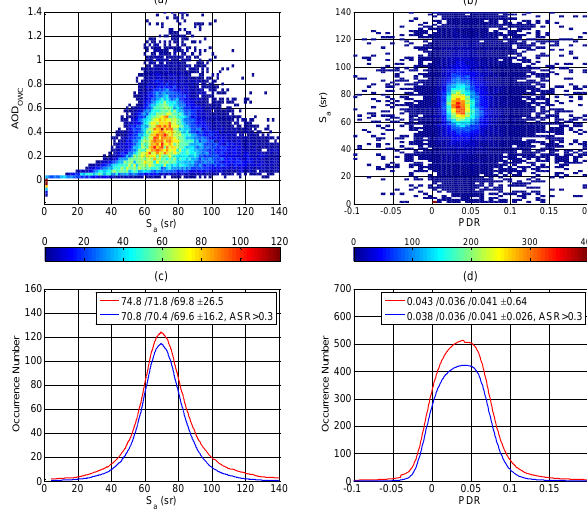
Figure 10. Analysis results for the smoke transport region as indi- cated by the red box in Fig. 7. The upper row shows 2-D distribu- tions of (a) AOD OWC vs. S a retrieved using AOD OWC as a con- straint and (b) S a vs. PDR, while the lower row shows histograms of (c) S a and (d) PDR occurrence frequencies. The S a distribution in (c) has a bin size of 0.1sr and is smoothed, while the bin size for S a in (a) and (b) is 1.5sr. The PDR distribution in (d) has a bin size of 0.001 and is smoothed, while the bin size in (b) is 0.006. The bin size for AOD in (b) is 0.025. The red curves in (c) and (d) include all data and the blue curves are screened data using ASR>0.2. The numbers in the legends of are mean/median/mode ± standard devi- ation of S a (c) and PDR (d)